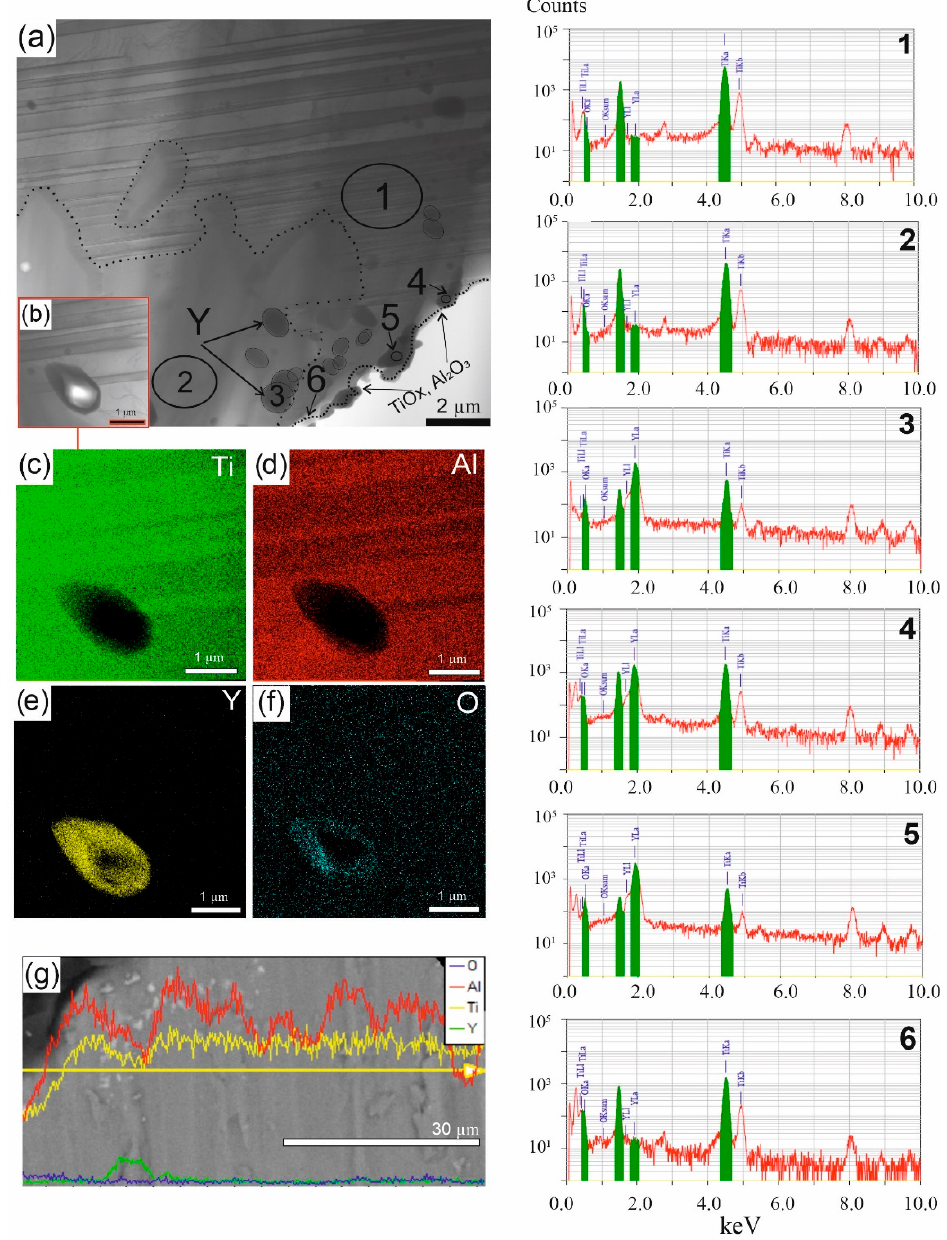
Figure 6. TEM images of the Ti-Al-Y alloy ( a , b ) with the super-spectral surface ( c – f ) and with the energy-dispersive spectral analysis (EDS) spectrum of relevant regions (1)–(6). SEM images of the concentration changes of the elements (Ti, Al, Y, and O) ( g ). Table 1. Summary table of the results of the EDS.